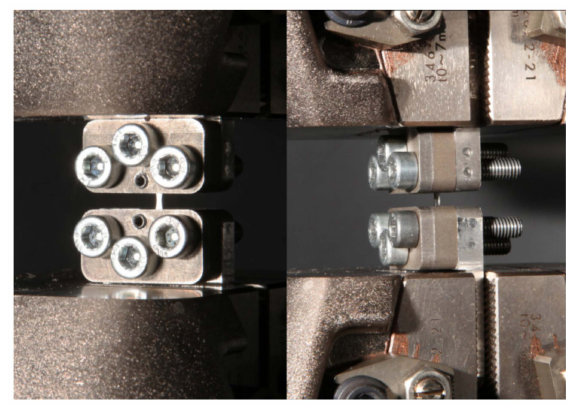
Figure 4. Stretching of the